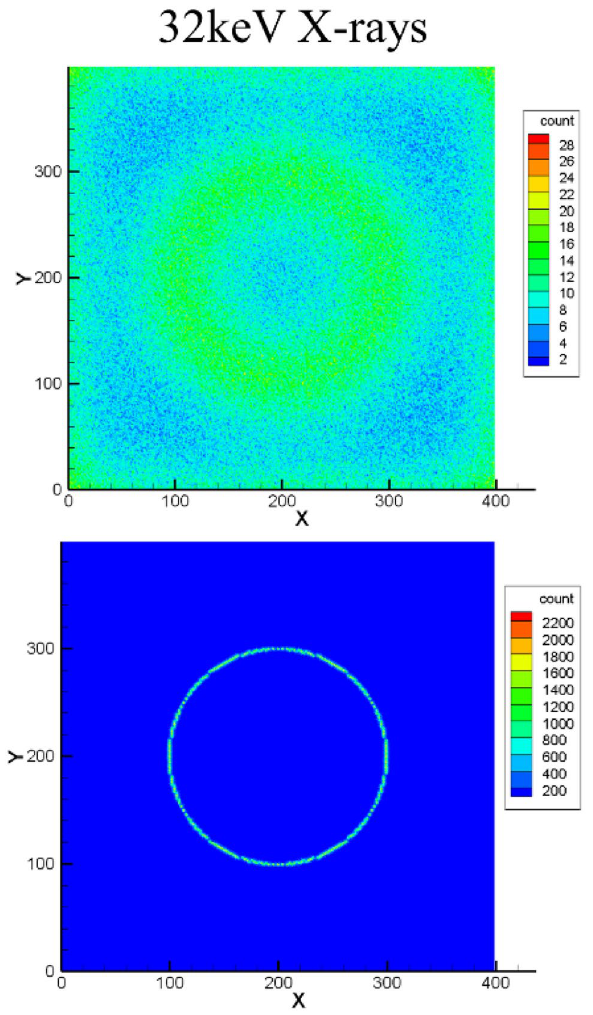
Figure 3. Hit counts of optical photons on pixels of the silicon imager generated using a circular pattern of incident 100,000 hard X-rays (32 keV) on the array of PEALPB detectors. Top row hit map shows the light generation without a microcapillary plate and the bottom row shows the same with the microcapillary plate.